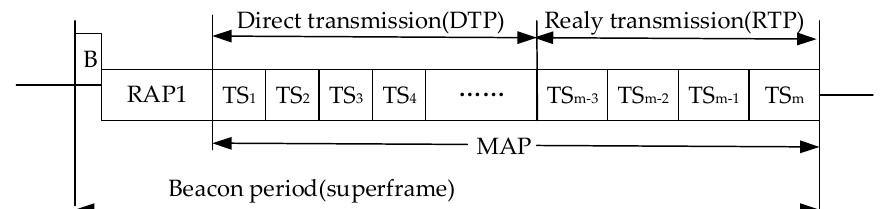
Figure 11. Superframe structure of the ATT protocol.